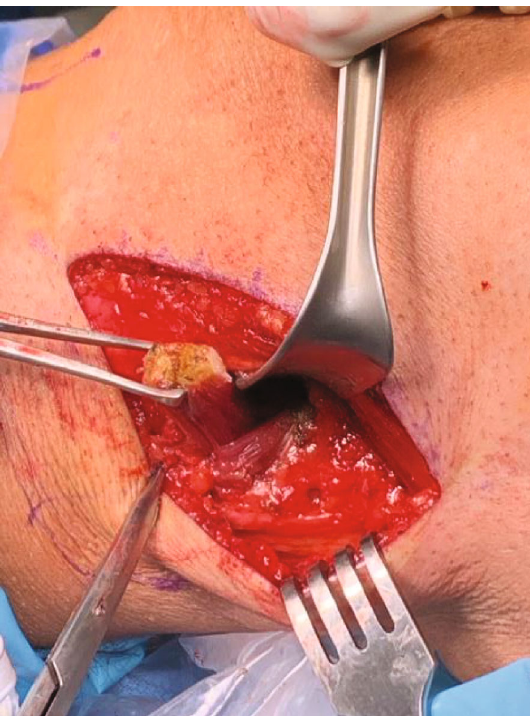
Figure 5: Fabella removal with Allis forceps.